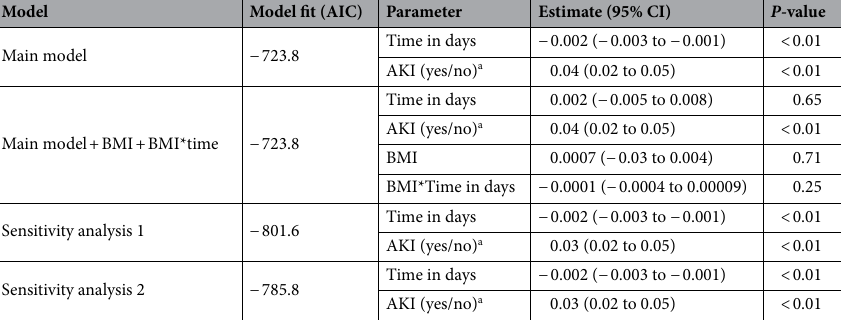
Table 2. Results from multilevel analyses. AIC Akaike Information Criterion, AKI Acute Kidney Injury, BMI body mass index. a AKI was entered in the models as a time-dependent dichotomous